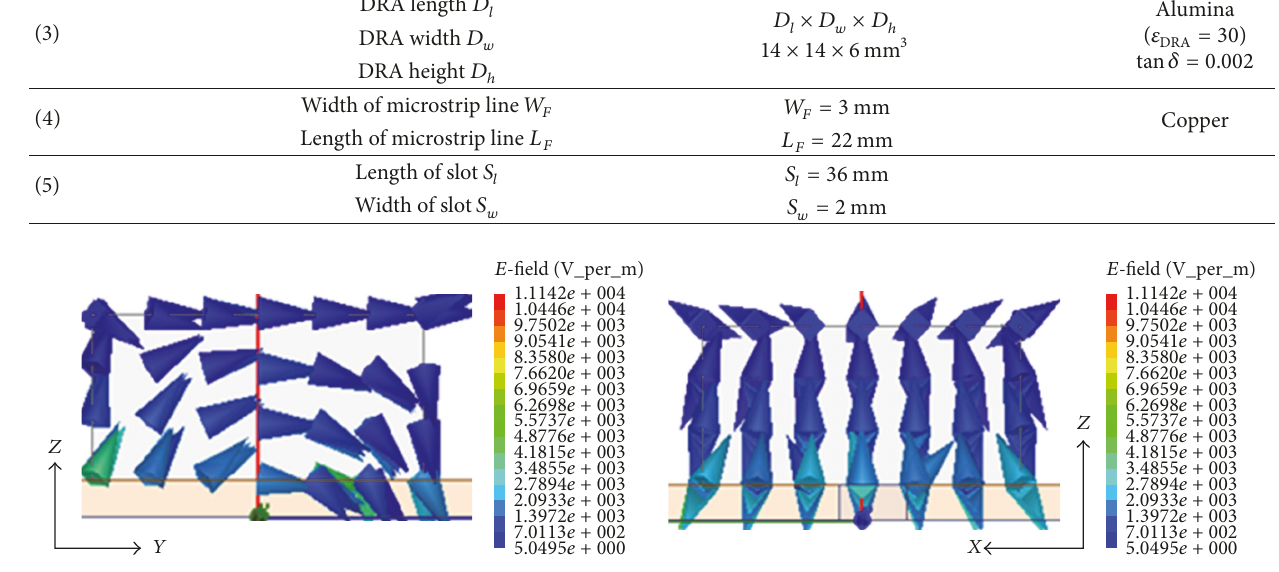
Figure 2: 𝐸 -field distribution on DRA. (a) 𝑌𝑍 -plane and (b) 𝑋𝑍 -plane.